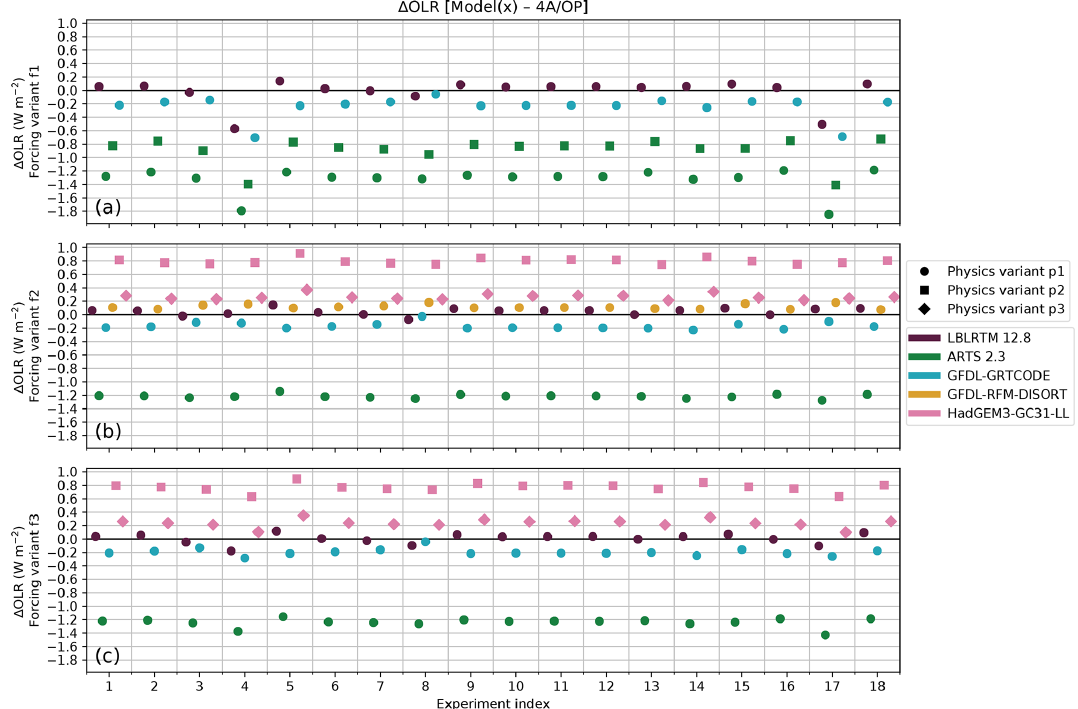
Figure A1. Means and standard deviations of OLR differences (model minus 4A/OP; Wm − 2 ) as a function of the experiment index. The five models compared to 4A/OP are represented by colors. The three forcing indices f1, f2, and f3 are respectively represented in individual panels (a–c) . The different physics variants are differentiated with marker shapes.